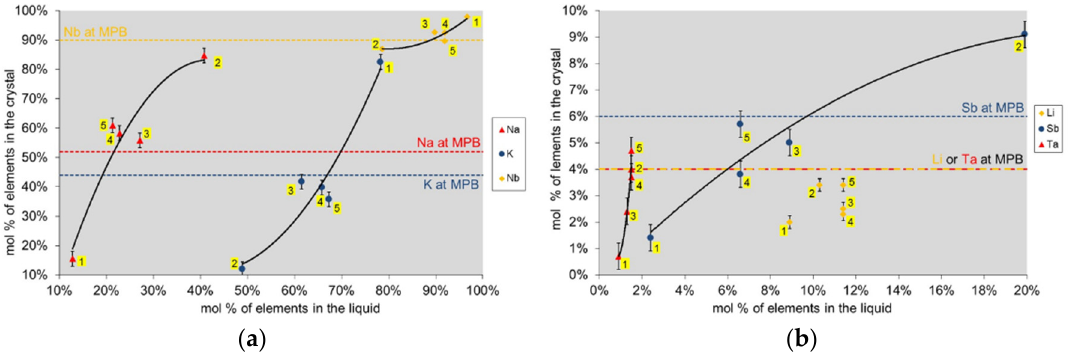
Figure 4. Segregation of elements in KNLSTN for the five growth attempts (number of attempt is written with yellow background). ( a ) Concentration of Na, K and Nb elements in crystal as a function of their initial content in liquid solution; and ( b ) concentration of Li, Sb and Ta elements in crystal as a function of their initial content in liquid solution. The dashed lines show the targeted compositions of Fu et al. [4].